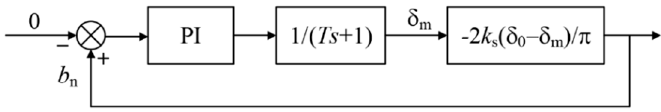
Figure 13. Schematic diagram of the adaptive dead time compensation strategy.